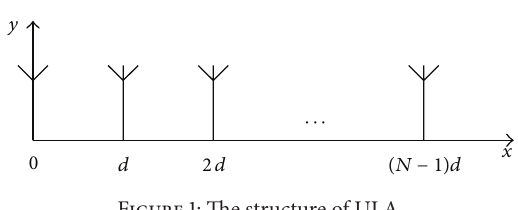
Figure 1: The structure of ULA.